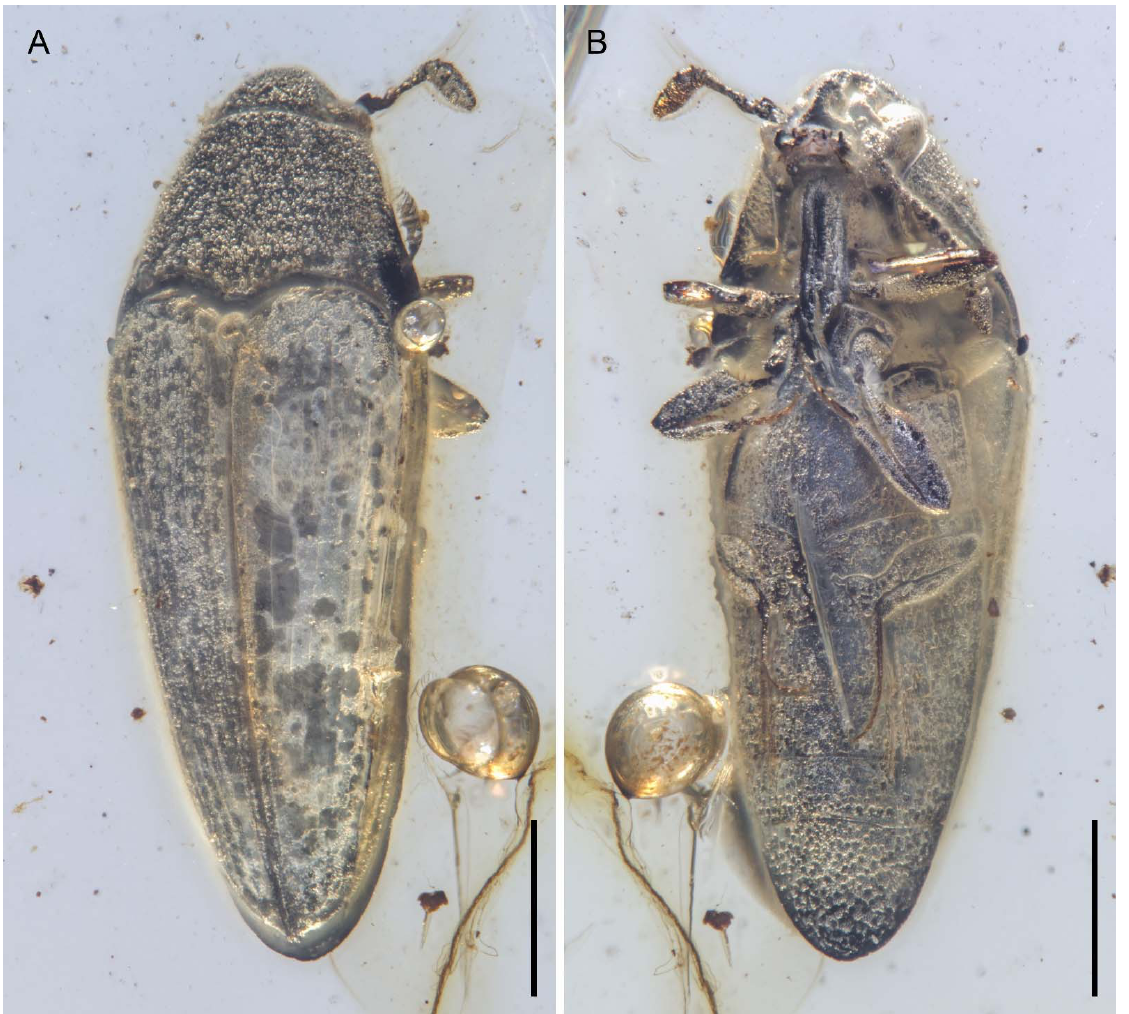
Figure 1. General habitus of Captopus depressiceps gen. et sp. nov. , holotype, NIGP173915, under incident light. ( A ) Dorsal view. ( B ) Ventral view. Scale bars: 500 μ m.